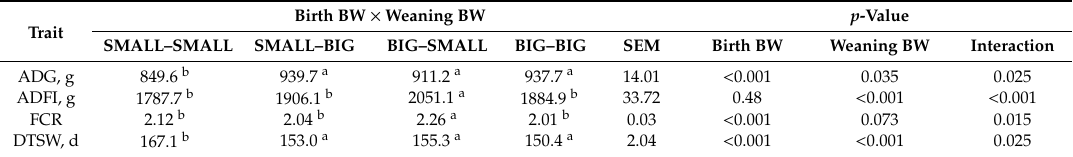
Table 3. Average daily gain (ADG), average daily feed intake (ADFI), feed conversion ratio (FCR) and days to target slaughter weight (DTSW) (Least square means [LS mean] ± Standard error mean [SEM]) from six weeks of age until all pigs reached 110 kg of target slaughter weight for four groups of pigs classified according to their birth BW as SMALL (BW ≤ 1.15 kg) or BIG (BW > 1.15 kg), and re-classified according to their weaning BW as SMALL (BW ≤ 5.5 kg) or BIG (BW > 5.5 kg). Birth BW × Weaning BW p -Value Trait SMALL–SMALL